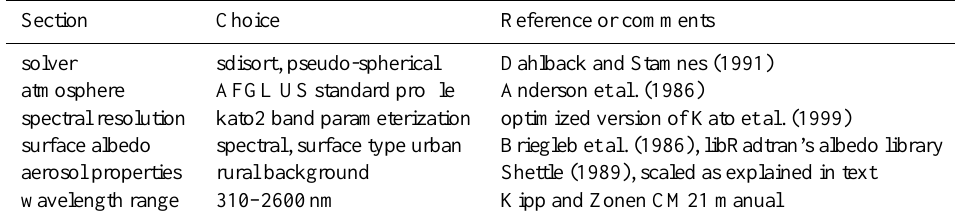
Table 1. Set-up of radiative transfer calculations.